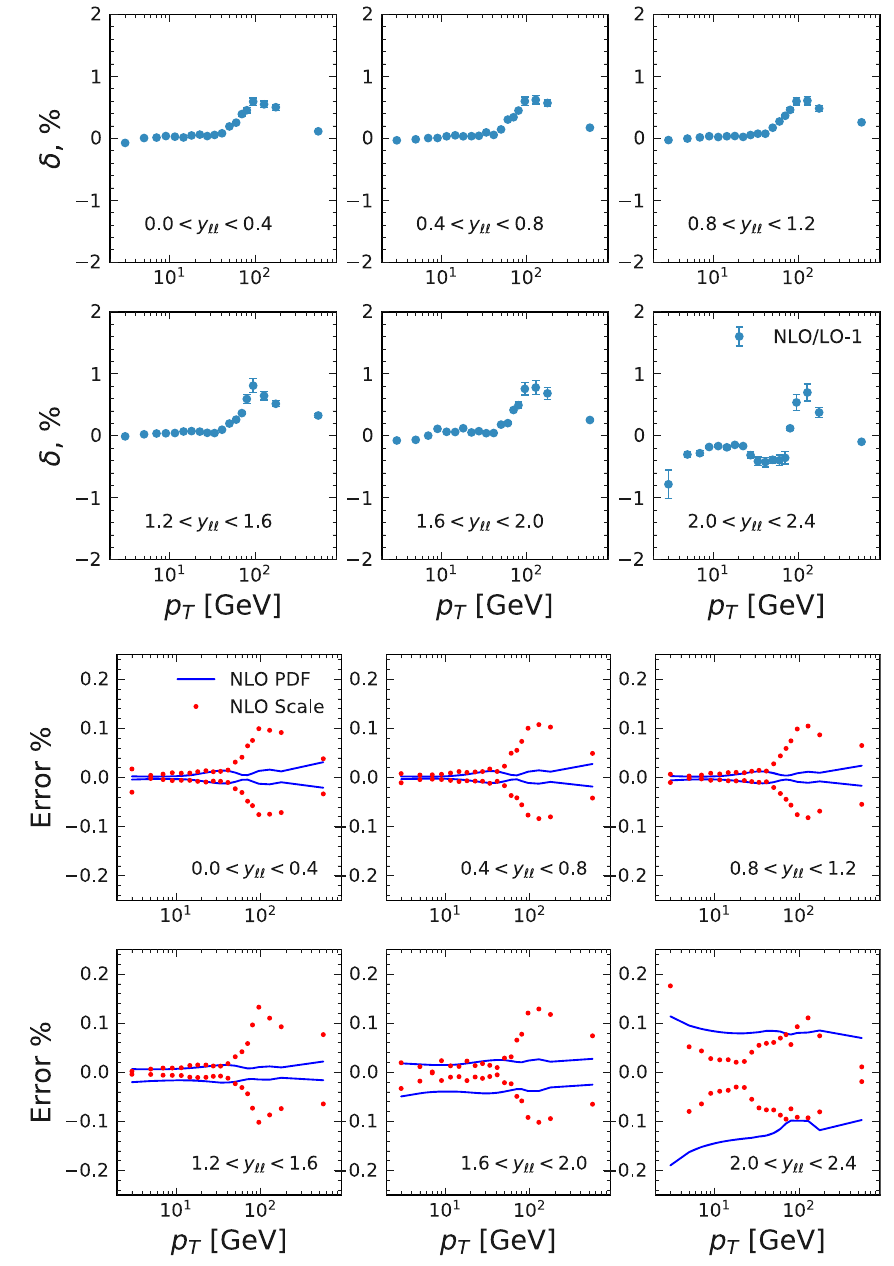
Fig. 2 Percentage difference between acceptance corrections calculated at NLO and LO. The error bars indicate total uncertainties of the NLO calculations